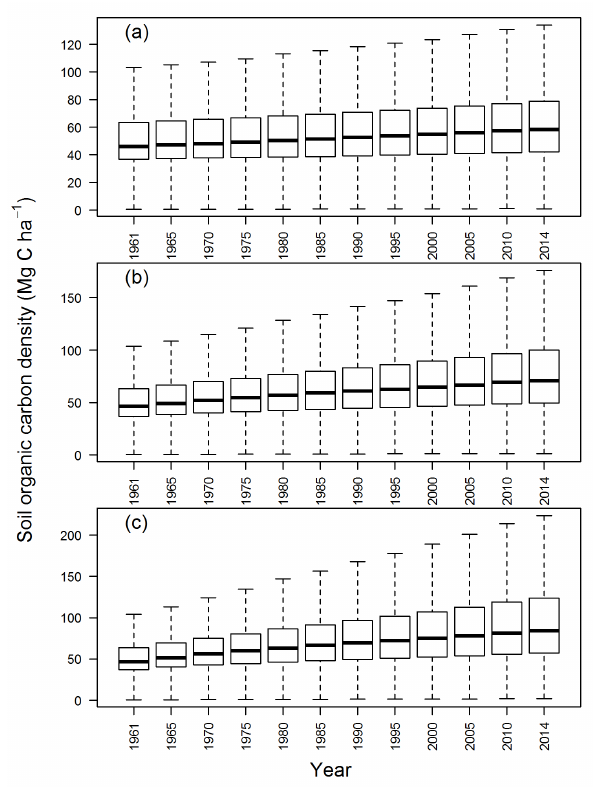
Figure 1. Temporal changes in the soil organic carbon (MgCha − 1 ) of the main global cereal cropping regions under different above- ground crop residue retention rates of 30% (a) , 60% (b) and 90% (c) . Box plots show the median and interquartile range with the whiskers extending to the most extreme data points within the 1.5 × (75–25%) data